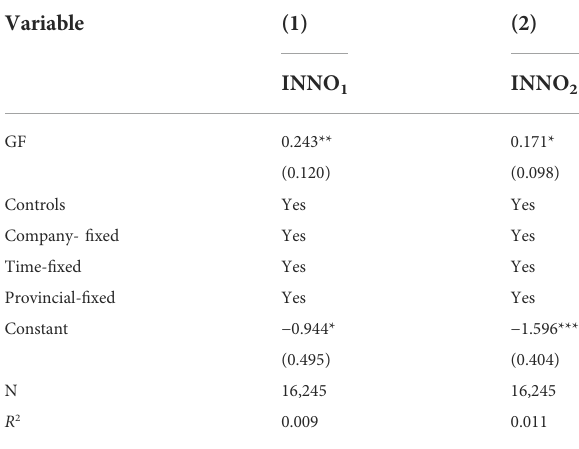
TABLE 7 Regression results of instrumental